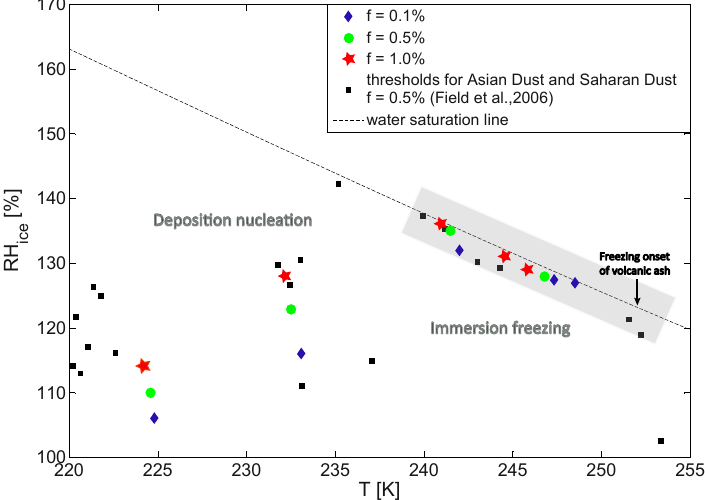
Fig. 5. Immersion freezing at water saturation and deposition nucleation: ice nucleation threshold conditions for different ice fractions f ( ◆ , ● , ⋆ ) produced by volcanic ash (EY01) compared to cloud chamber experiments (Field et al., 2006) with Saharan and Asian Dust ( (cid:4) ) – the shaded area illustrates the measurement uncertainty of RH ice at water saturation. regions of droplet activation. The relative humidity over ice (RH ice ) is measured with an uncertainty of ± 3–5 % (Fahey et al.,